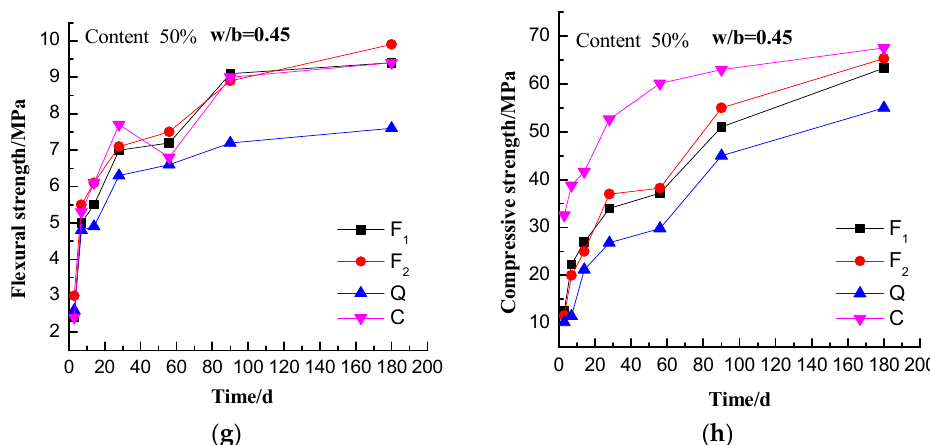
Figure 3. Development of the flexural ( a , c , e , g ) and compressive ( b , d , f , h ) strength of mortars under standard curing conditions.